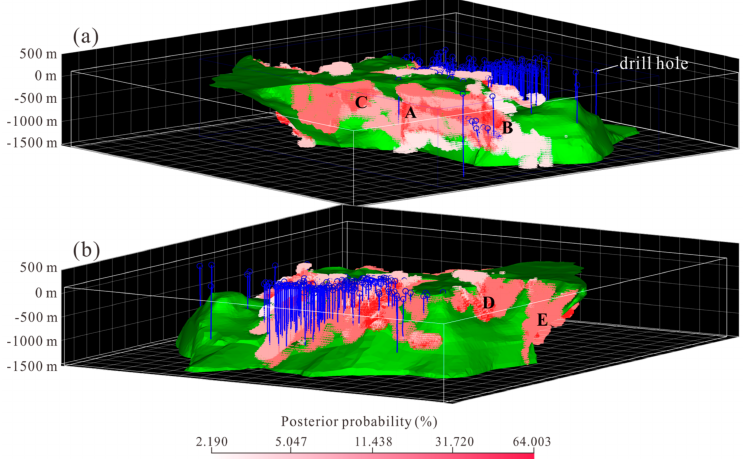
Figure 14. The spatial association of high potential blocks with the Yueshan intrusion and drillholes. Showing the exploration targets, A, B, C, D and E that based on the high potential blocks, ( a ) the view from south and ( b ) the view from